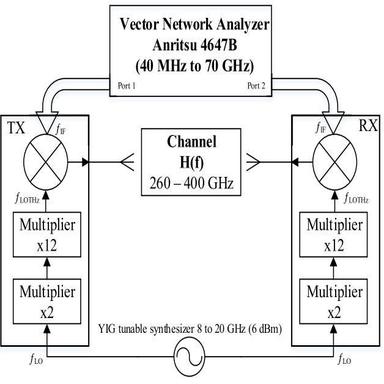
Block diagram of THz Band measurement setup.